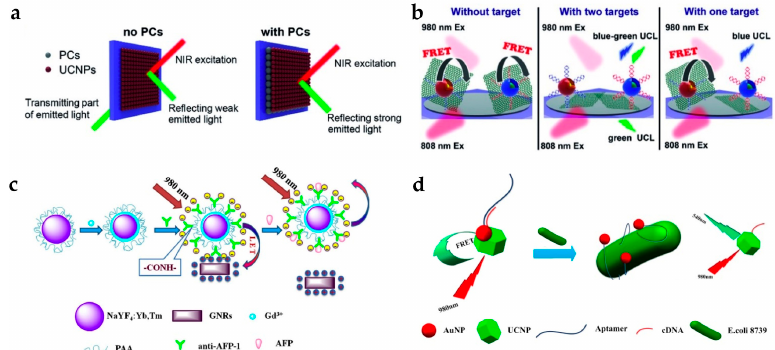
Figure 5. ( a ) Schematic of optical pathway when UCNPs are deposited on the PCs; ( b ) The principle of simultaneous detection of multiple targets; ( c ) Schematic illustration of α -fetoprotein (AFP) detection using gold nanorods (GNRs) as a quencher; ( d ) Schematic representation of bacteria detection using AuNPs as a quencher. Reprinted with permission from